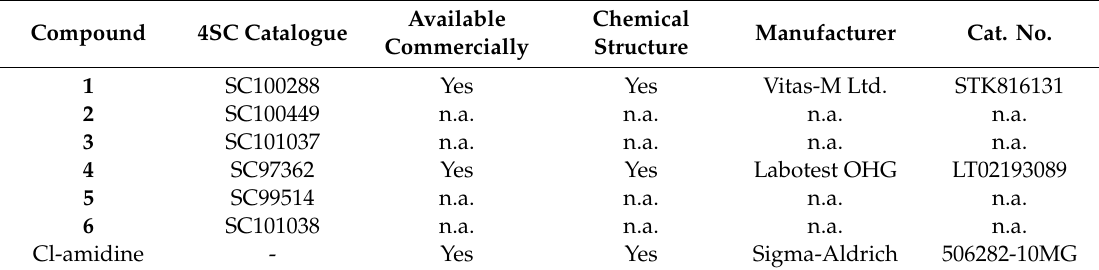
Table 2. List of the tested